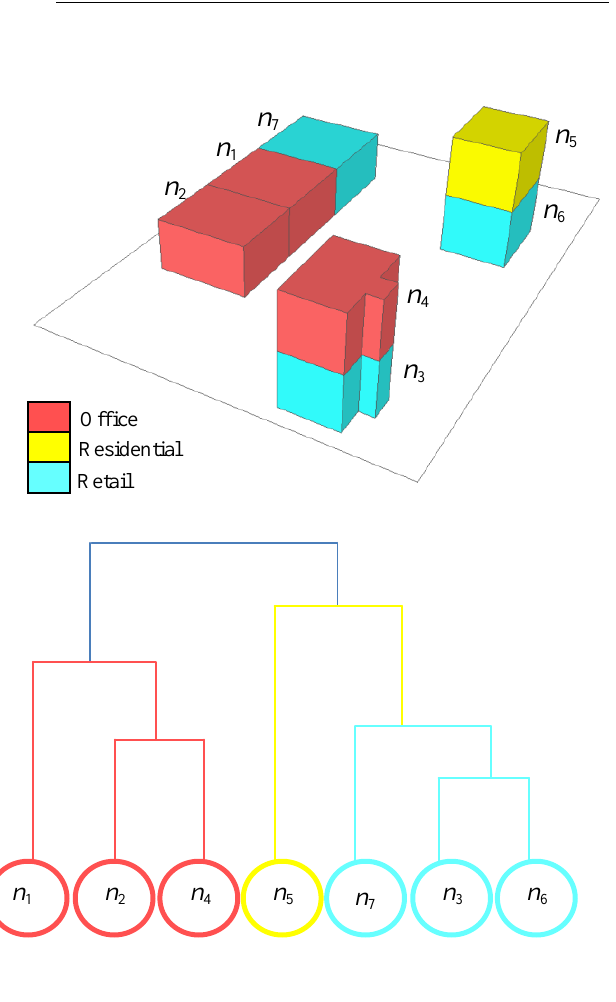
Figure 4. Dendrogram tree for 3D